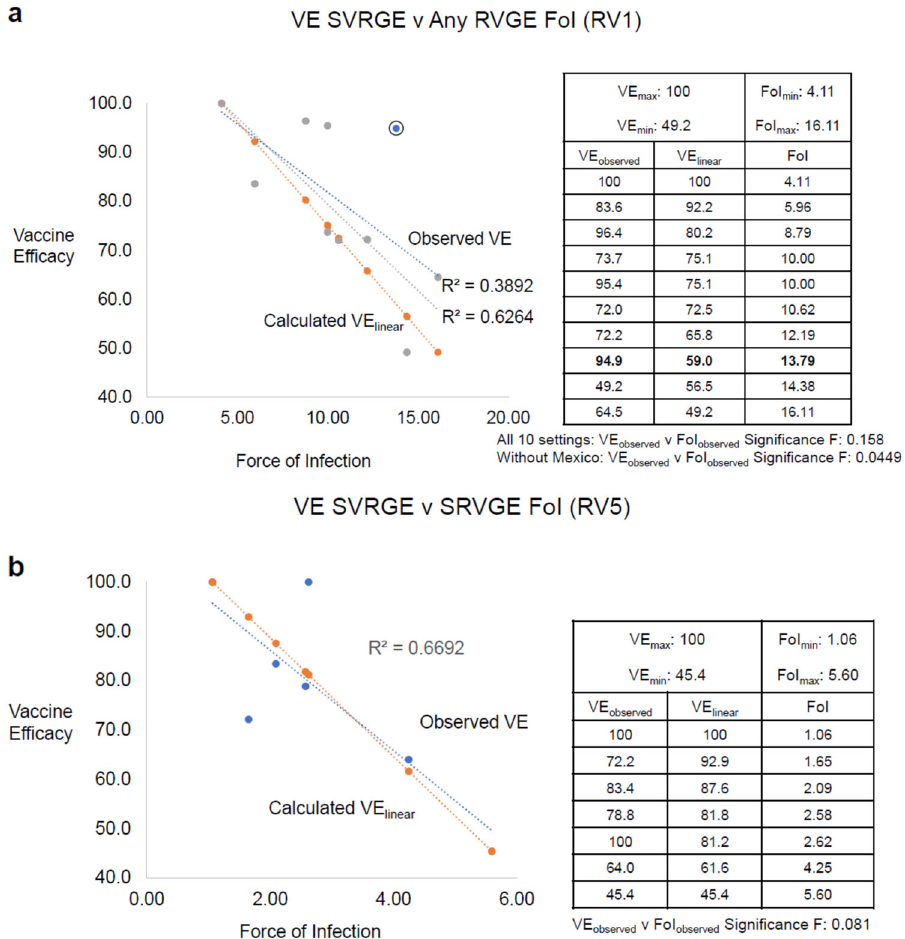
Fig. 3 Vaccine Ef fi cacy (VE) as a function of Force of Infection (FoI) for rotavirus vaccines. a RV1: Best fi t trendline analysis of observed vaccine ef fi cacy (VE observed ) as a function of observed force of infection (FoI observed ) is shown as a linear relationship for all 10 countries (blue dotted line) and for 9 countries (exclusion of the outlier, encircled blue dot; gray dotted line) with a R 2 of 0.3892 and 0.6264, respectively. Regression analyses of VE observed as a function of FoI observed in the embedded table have Signi fi cance Fs of 0.158 and 0.0449. Using the VE linear equation (see Box 2, Vaccine ef fi cacy as a function of force of infection), the observed VE max , VE min , FoI max , FOI min and FoI observed were used to calculate the VE linear in the embedded table and the calculated VE linear shown graphically (orange dotted line). b RV5: Best fi t trendline analysis of observed vaccine ef fi cacy (VE observed ) as a function of observed force of infection (FoI observed ) is shown as a linear relationship (blue dotted line) with a R 2 of 0.6692. A regression analysis of VE observed as a function of FoI observed in the embedded table has a Signi fi cance F of 0.081. Using the VE linear equation (see Box 2, Vaccine ef fi cacy as a function of force of infection), the observed VE max , VE min , FoI max , FOI min and FoI observed were used to calculate the VE linear in the embedded table and the calculated VE linear shown graphically (orange dotted